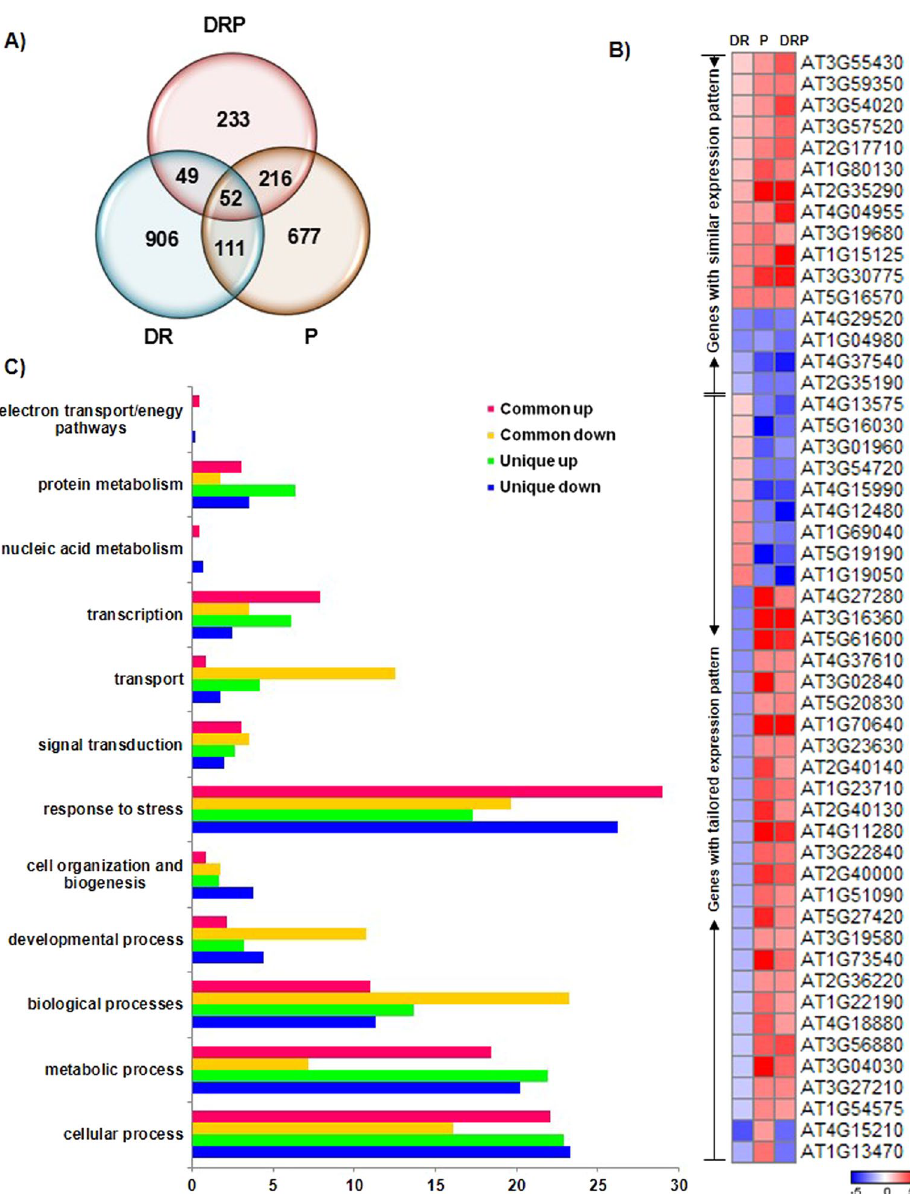
Figure 1. Overview of transcriptome profile of Arabidopsis thaliana exposed to drought-recovery- pathogen treatment in comparison to drought recovery and pathogen treatments. A . thaliana was exposed to Pseudomonas syringae pv. tomato DC3000 (Pst DC3000; P) and combined drought-recovery-pathogen (DRP) treatments as outlined in Figure S1. Microarray hybridization on Affymetrix WT gene chip array was conducted using total RNA isolated from leaf samples (38-d-old plants) harvested at 24 hours post treatment (hpt). Differentially expressed genes (DEGs) in each stress treatment were identified in comparison to control conditions and threshold was set at change greater than 2 fold and ANOVA p value < 0.05. Differentially expressed genes under drought recovery (DR) were retrieved from Coolen et al . 30 . Venn diagram between DEGs in individual (DR and P) and combined (DRP) stress revealed the presence of transcripts exclusively under DRP stress and were regarded as ‘unique’ genes, and ‘common’ transcripts shared between individual and combined stresses ( A ). Expression profile of genes common among DR, P and DRP is presented in the form of heat map. Common transcripts were categorized as genes with similar expression pattern in all the three stress conditions and as genes with ‘tailored’ expression pattern under different stresses (up-regulated vs. down-regulated and vice versa) ( B ). Expression values were used to plot heat maps using GENE-E software (http://www. broadinstitute.org/cancer/software/GENE-E/). Colour bar scale shows the fold change range with a red and blue colour representing up- and down-regulation respectively. Corresponding gene names and descriptions for the gene IDs presented in the figure are provided in Supplementary File S1. Genes common to individual and combined stress and genes unique to the DRP stress were functionally categorized and represented based on gene ontology (GO) biological process ( C